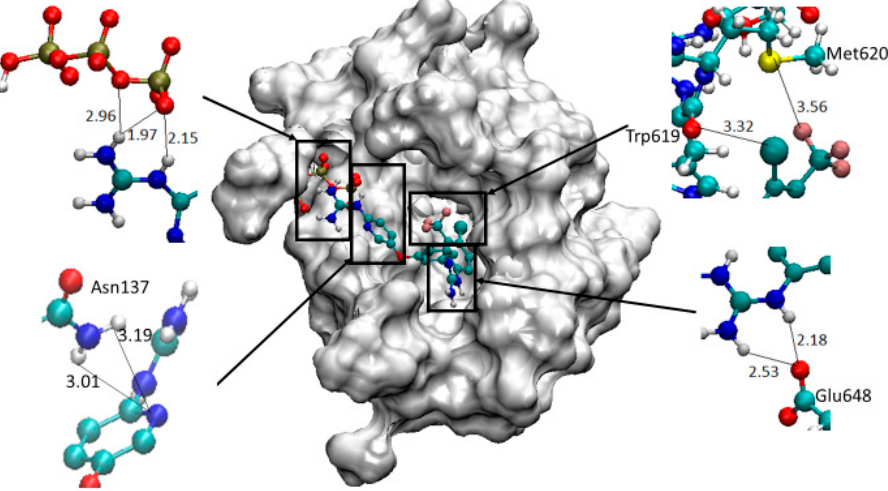
Figure 3. Docking of derivative 2 in the TP-containing BRAF simplified model indicating the bifurcated (up left, bottom left and right) and single (up right) hydrogen bond (HB) interactions observed. Distances are expressed in Å.